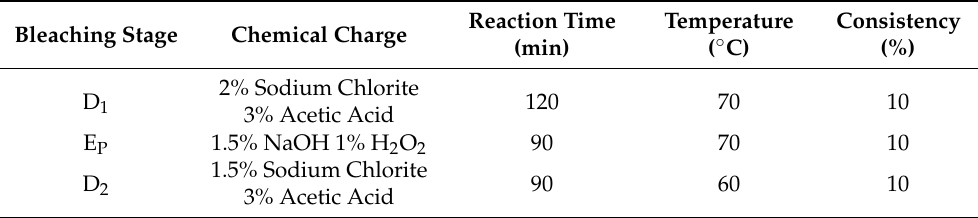
Table 1. Bleaching condition for bleached kenaf core pulp.